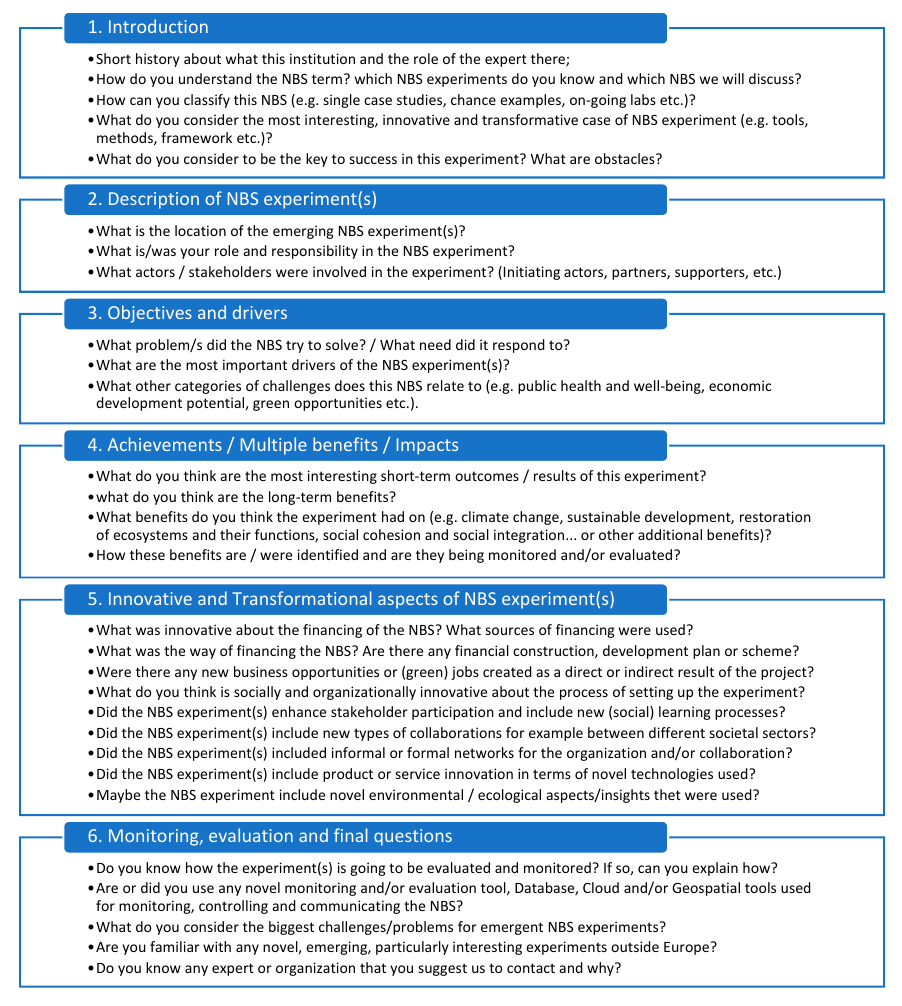
Figure 3. Interview template including the six-step iteration applied in the Leipzig study.